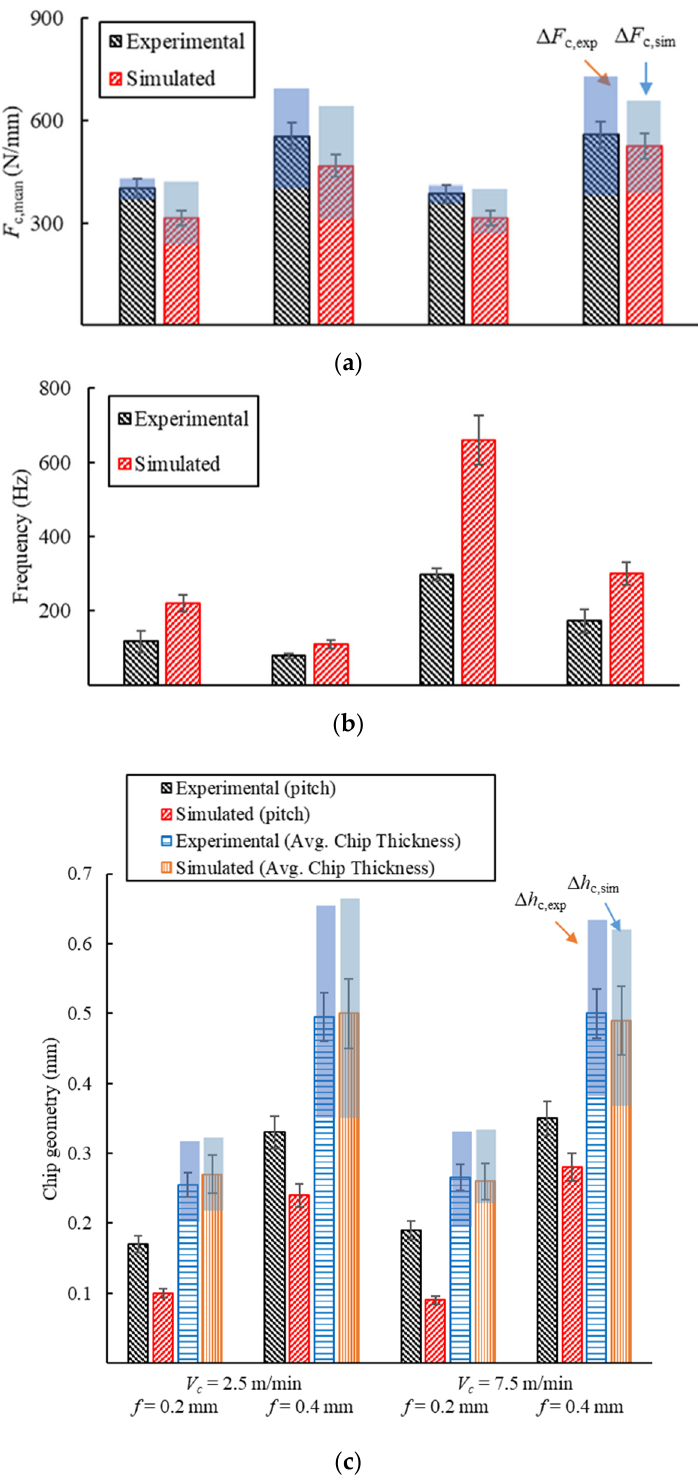
Figure 16 . Effect of cutting conditions on different machining outcomes: ( a ) cutting force; ( b ) frequency and ( c ) chip geometry. Comparison between experimental and FEM results.